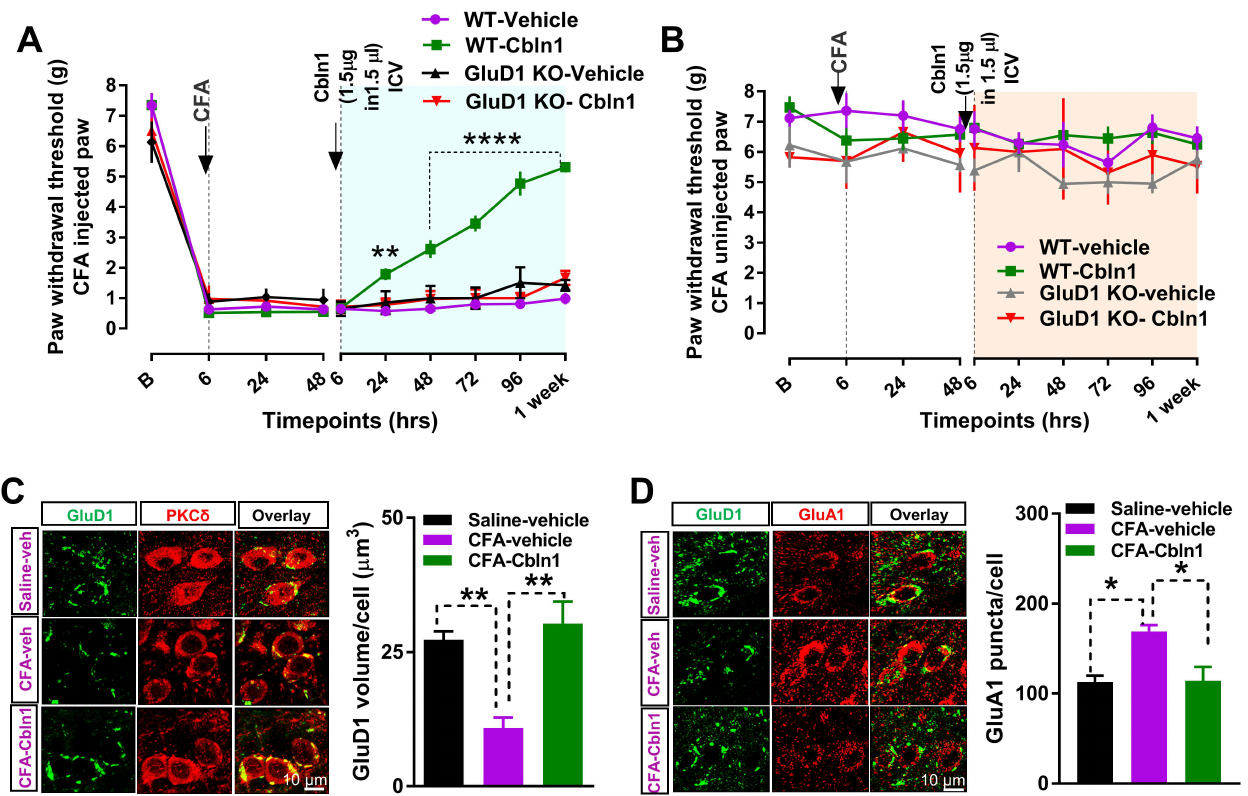
Figure 5. Recombinant Cbln1 administration normalizes synaptic dysfunction in the CeA in inflammatory pain. ( A ) Intrac- erebroventricular administration of Cbln1 (1.5 µ g in 1.5 µ L PBS) 48 h after CFA also attenuated mechanical hypersensitivity for at least one week. Two-way repeated measures ANOVA, F (3, 14) = 12.81, p = 0.0001, Bonferroni’s post hoc test, WT CFA-vehicle ( n = 4 mice) vs. WT CFA-Cbln1 ( n = 6 mice), ** p = 0.0051, **** p < 0.0001. No effect of Cbln1 was observed in GluD1 KO ( n = 4 mice (vehicle), 4 mice (Cbln1)). ( B ) No change in mechanical threshold in von Frey analysis in control (non-CFA injected) paw. ( C ) Immunohistochemical analysis of right CeLC for the effect of ICV administration of recombinant Cbln1 on perisomatic GluD1 volume in the CFA pain model. Recombinant Cbln1 restored GluD1 levels in CFA mice compared to mice injected with PBS (One-way ANOVA, treatment F (2, 9) = 14.38, p = 0.009; Bonferroni’s multiple comparison; Saline-vehicle ( n = 4 mice): 27.3 ± 1.53, vs. CFA-vehicle ( n = 4 mice): 10.87 ± 1.94, ** p = 0.068; CFA-vehicle vs. CFA-Cbln1 ( n = 4 mice): 30.3 ± 4.08, ** p = 0.0023). ( D ) Recombinant Cbln1 normalized surface GluA1 upregulation in the right CeLC in CFA pain model (One-way ANOVA treatment F (2, 9) = 9.23 p = 0.006; Bonferroni’s multiple comparison; Saline-vehicle ( n = 4 mice) vs. CFA-vehicle ( n = 4 mice): 112.9 ± 7.07 vs. 169.2 ± 6.83, * p = 0.013 and vs. CFA-Cbln1 ( n = 4 mice): 114.2 ± 15.4, * p =